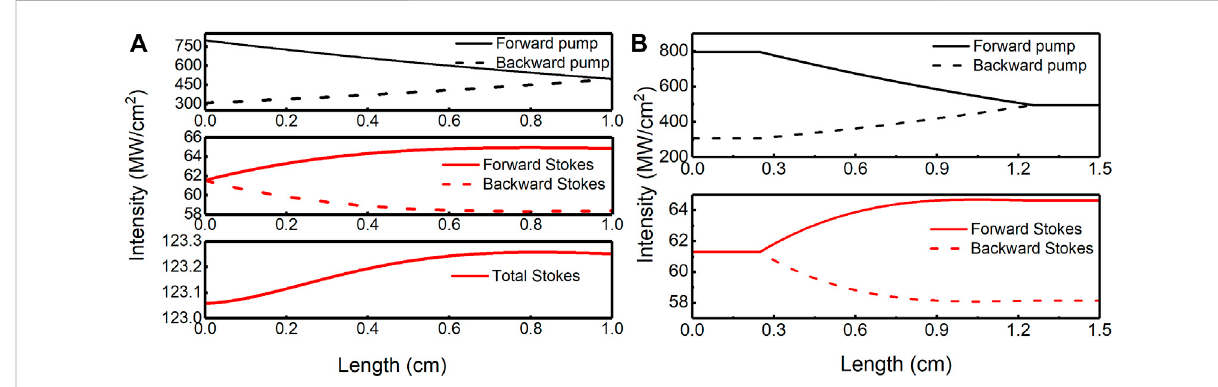
FIGURE 2 Intensity distributions of the pump and Stokes with the cavity. (A) 1-cm length of the cavity. (B) 1.5-cm length of the